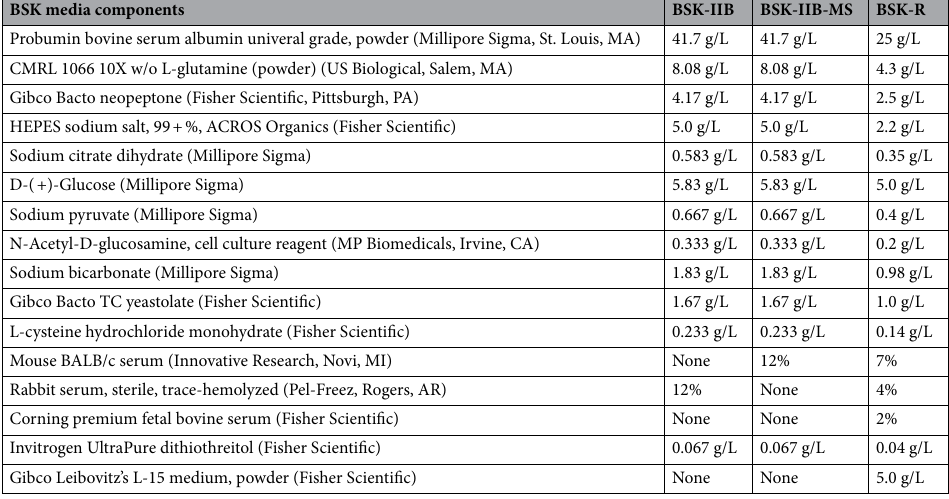
Table 1 provides a recipe for the final media formulation, designated BSK-R, which includes 5 g/L Leibovitz’s L-15 and components of BSK-IIB adjusted to 60%, with the exception of 4.3 g/L CMRL-1066 w/o L-glutamine, 5.0 g/L glucose as well as 2.2 g/L HEPES and 0.98 g/L sodium bicarbonate, which were adjusted to give a final pH of 7.5. Serum was added to a final concentration of 13% (7% mouse serum, 4% rabbit serum and 2% fetal